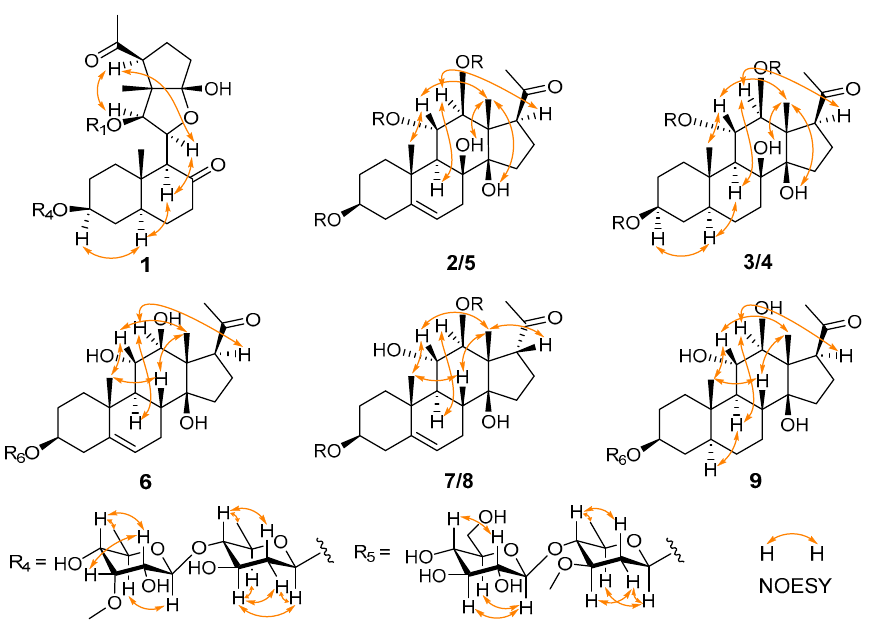
Figure 3. Selected NOESY correlations of compound 1 – 9 .